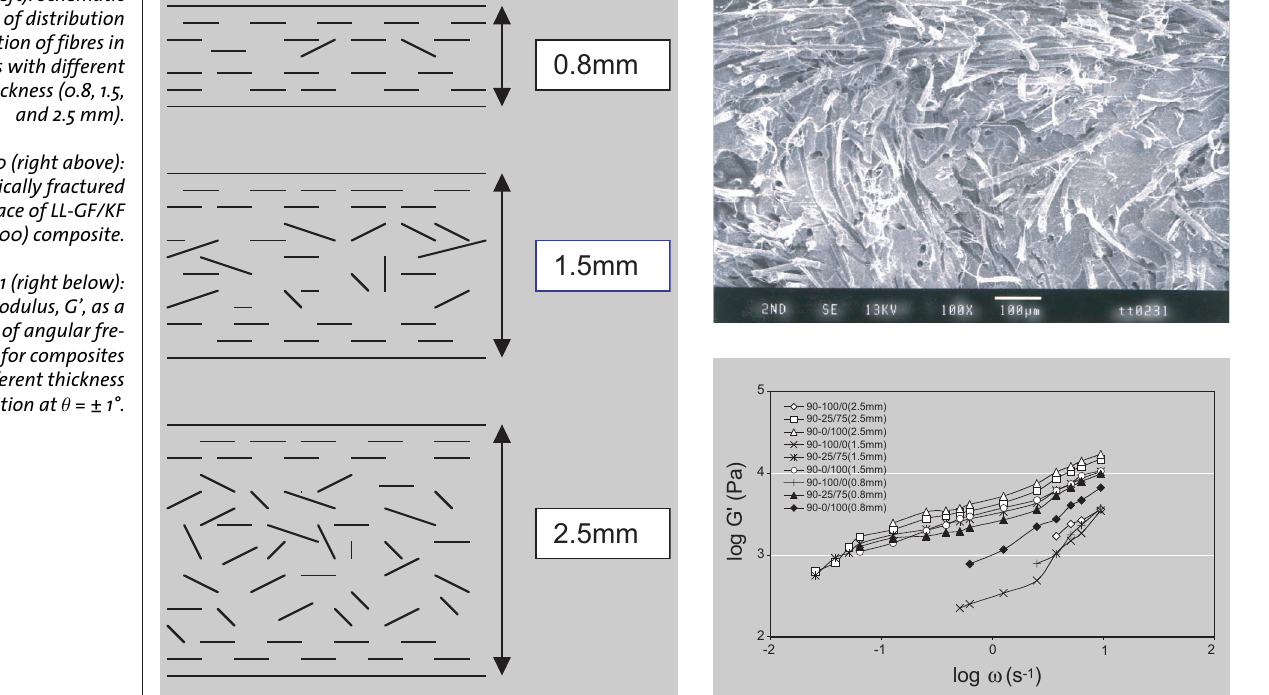
Figure 9 (left): Schematic presentation of distribution and orientation of fibres in composites with different thickness (0.8, 1.5, and 2.5 mm). Figure 10 (right above): Cryogenically fractured surface of LL-GF/KF (80-0/100) composite. Figure 11 (right below): Storage modulus, G’, as a function of angular fre- quency, w , for composites having different thickness and composition at q = ± 1°.